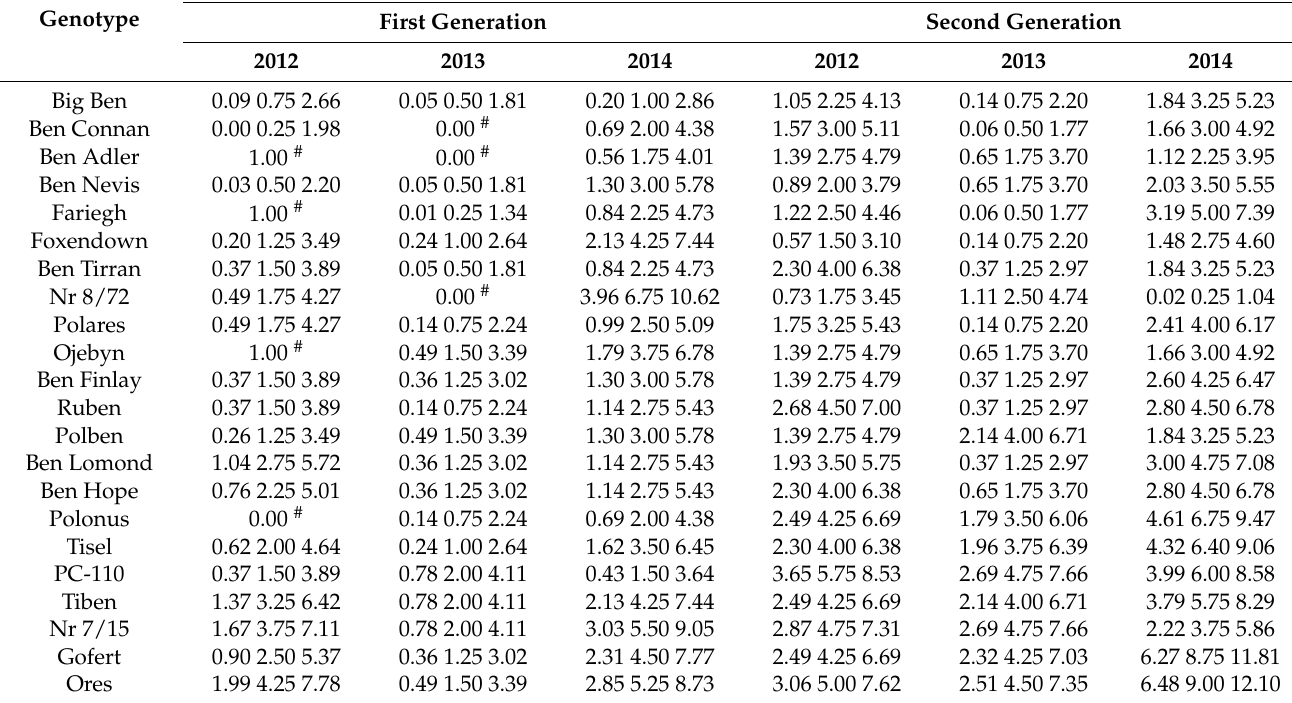
Table 3. Estimated mean number of eggs from four five-shoot replications per genotype. The cells show estimates with 95% confidence intervals estimated using generalized linear models. The genotypes are sorted according to the increasing mean probability across the three years and both pest generations.